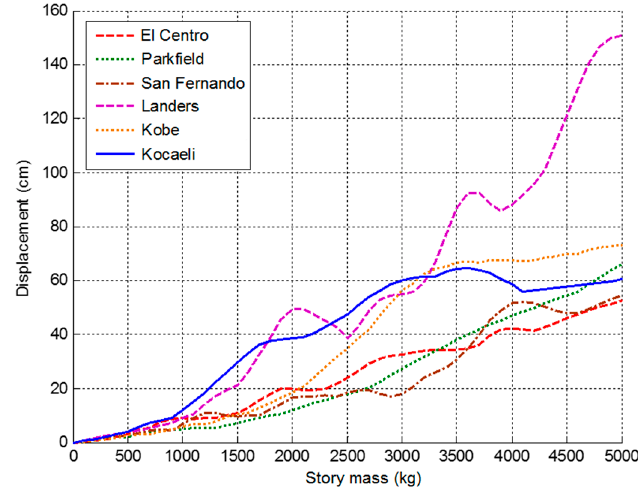
Figure 4. Peak displacement for the top story of building with respect to story mass.